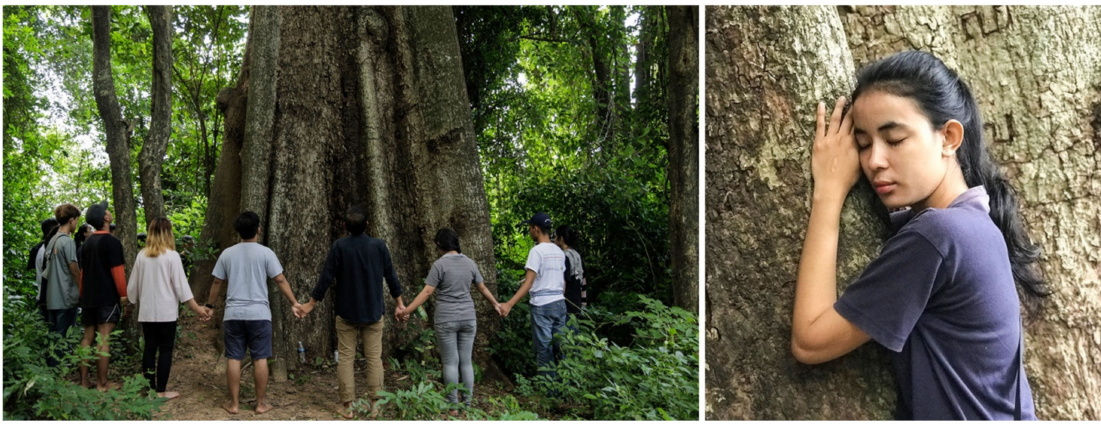
Figure 2. Photos of Cambodian youth visiting a forest as part of the Young Eco Ambassador Der Prey